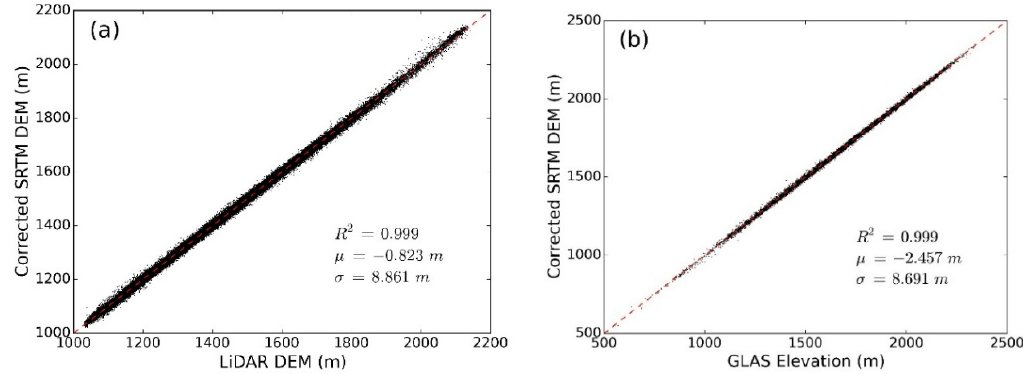
Figure 9. ( a ) Scatter plot between the corrected SRTM DEM and the LiDAR DEM; ( b ) Scatter plot between the corrected SRTM DEM and GLAS elevations within GLAS footprints. R 2 represents the coefficient of determination, and µ and σ represent the mean and standard deviation of differences between the corrected SRTM DEM and the LiDAR DEM (or GLAS elevations) (SRTM DEM minus LiDAR DEM or GLAS elevations). The red dashed line represents the 1:1